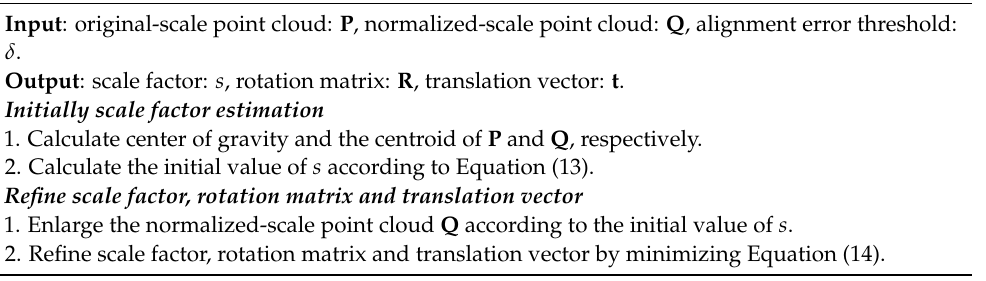
Algorithm 3. Determining scale factor from point cloud registration.